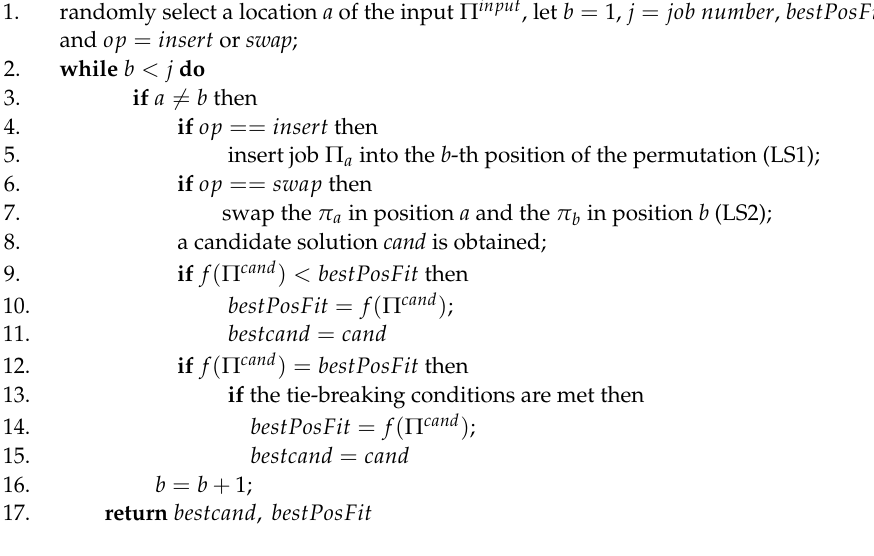
Algorithm 4 The process of two